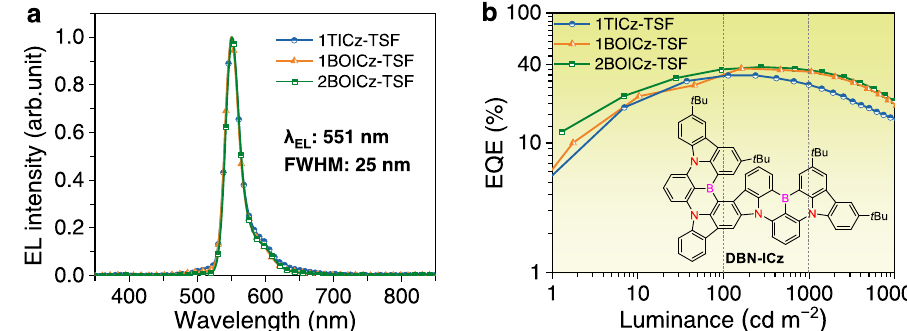
Fig. 5 | TSF-OLED device performances. a Normalized EL spectra under 1000cdm − 2 . b EQE versus luminance characteristics, and the narrowband yellow MR emitter Table 2 | Summary of the EL performance of TADF-OLEDs and TSF-OLEDs devices Device